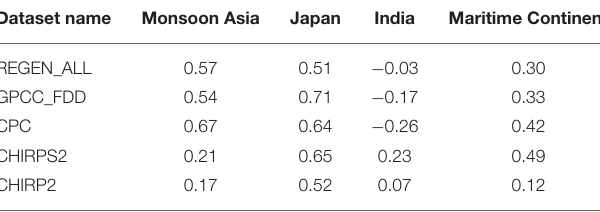
TABLE 3 | Temporal correlation of regionally averaged relative differences (in %) for the annual wettest day (Rx1day) for each considered products with APHRODITE, calculated for each product covering the period of